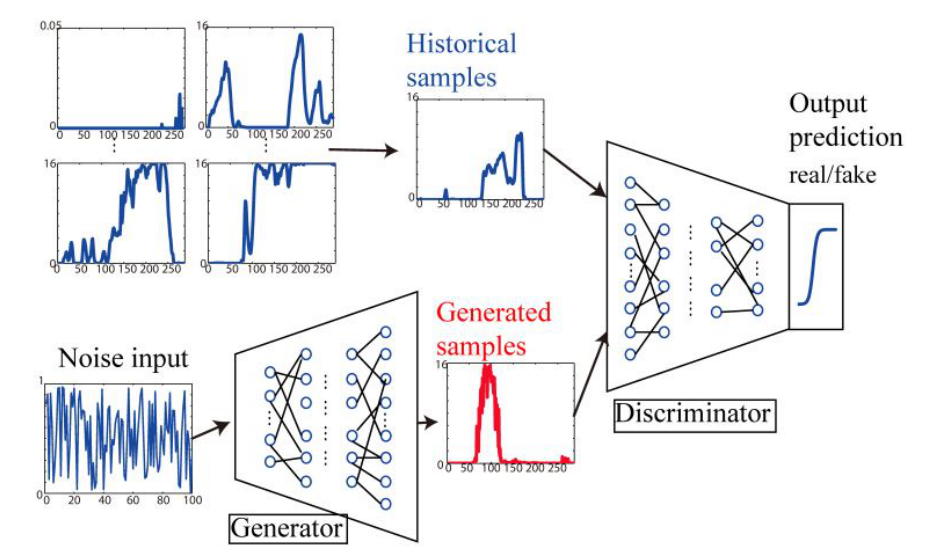
Figure 2. Architecture of GANs training procedure according to Chen et al. (2018, p.